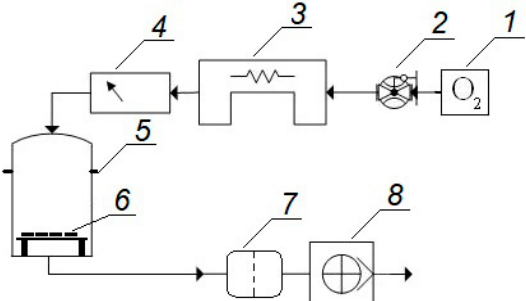
Figure 2. Layout diagram of test stand for ozone treatment of construction material samples: 1 —oxygen concentrator, 2 —adjustable flow meter, 3 —ozone generator, 4 —ozone concentration meter, 5 —reaction chamber, 6 —samples subjected to surface layer modification, 7 —ozone destroyer, 8 —suction pump.